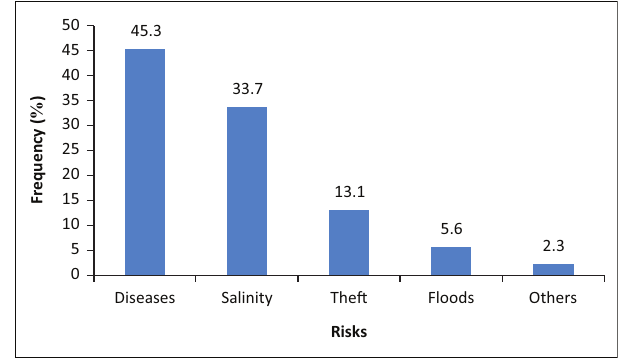
FIGURE 4: Risks facing Goba sub-ward residents. TABLE 2: Most commonly reported water-related diseases.